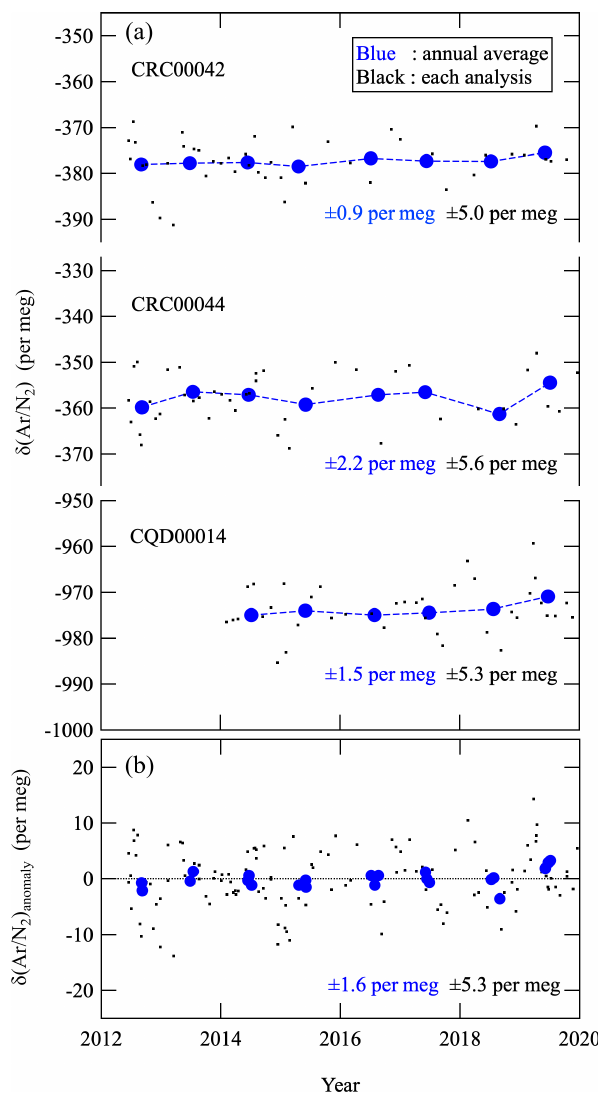
Figure 1. (a) Each analysis value (black dots) and corresponding annual average (blue circles) of δ (Ar / N 2 ) of three secondary stan- dards against the primary standard air. (b) Anomalies of δ (Ar / N 2 ) of the three secondary standards shown in panel (a)